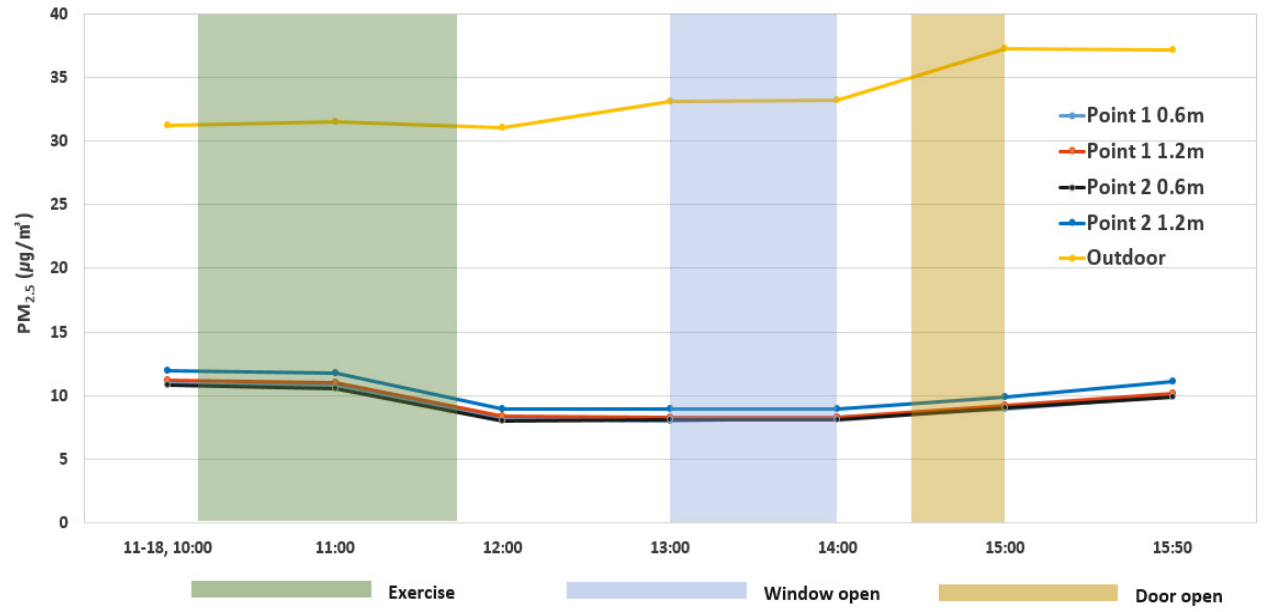
Figure 9. Measurement of the ultrafine-dust concentration (PM2.5) according to activities and window/door openings in the MPA-space of A elementary school on 18 November 2020.